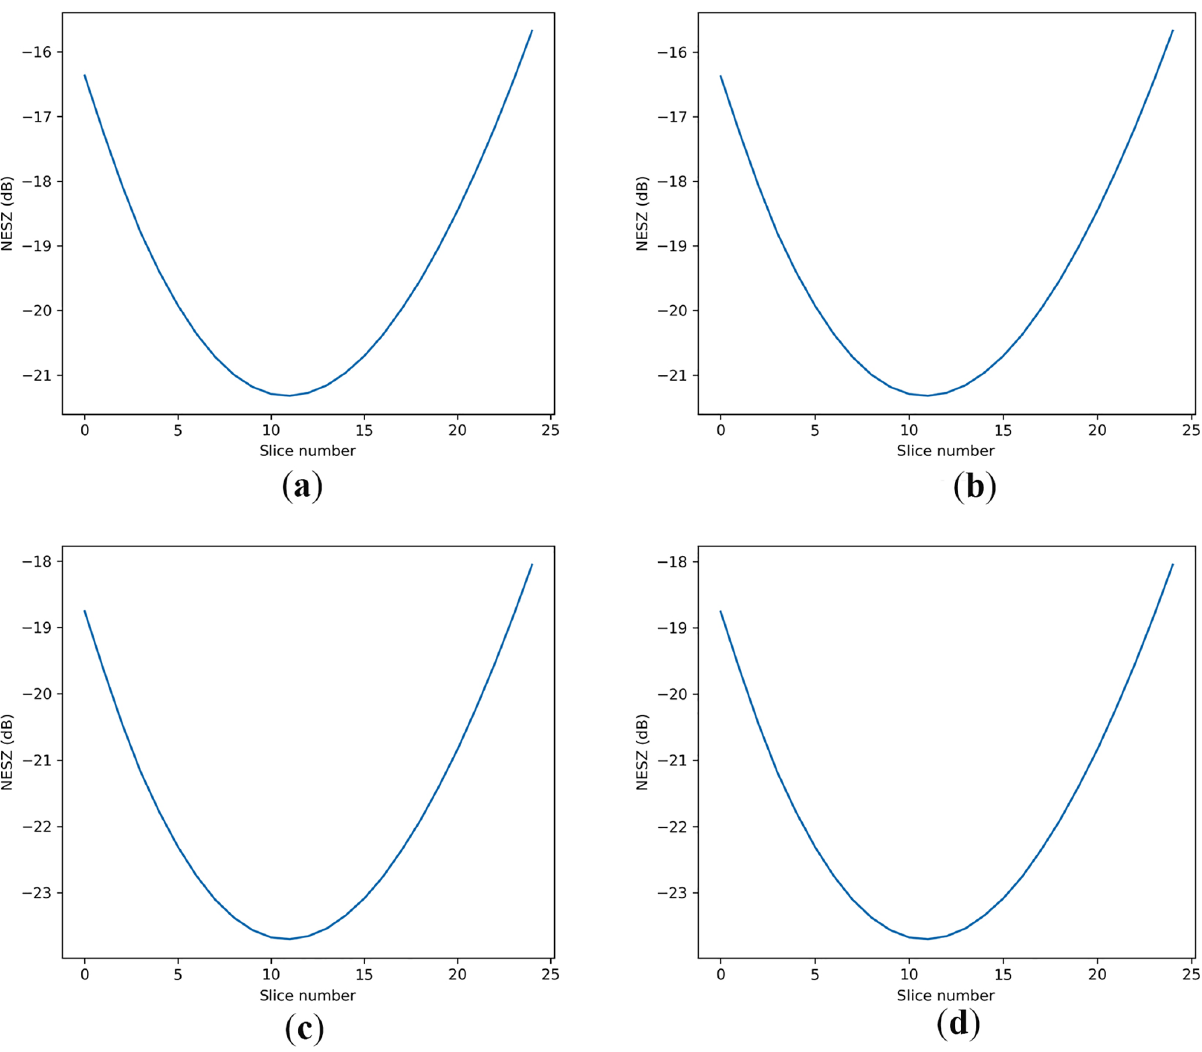
Figure 4. WindRad NESZ distribution as a function of slice number. (a) Ku-band HH polarization. (b) Ku-band VV polarization. (c) C-band HH polarization. (d) C-band VV